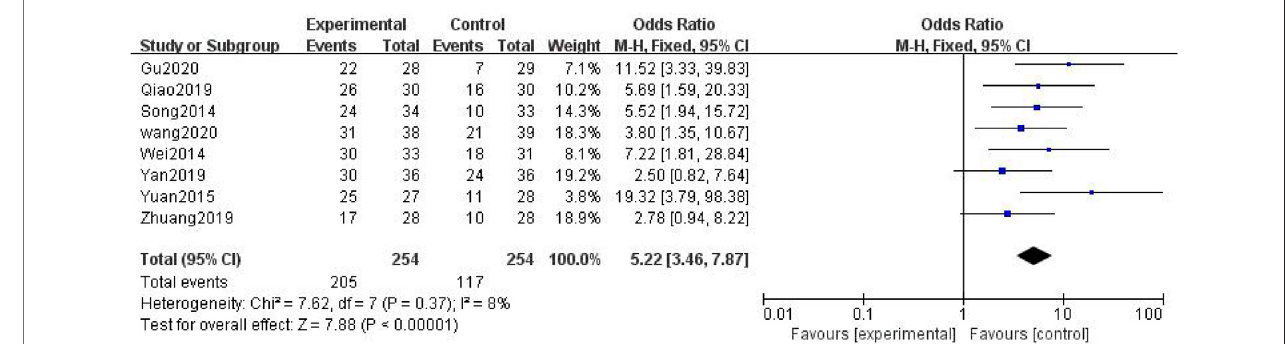
FIGURE 10 | TCM syndrome effect.